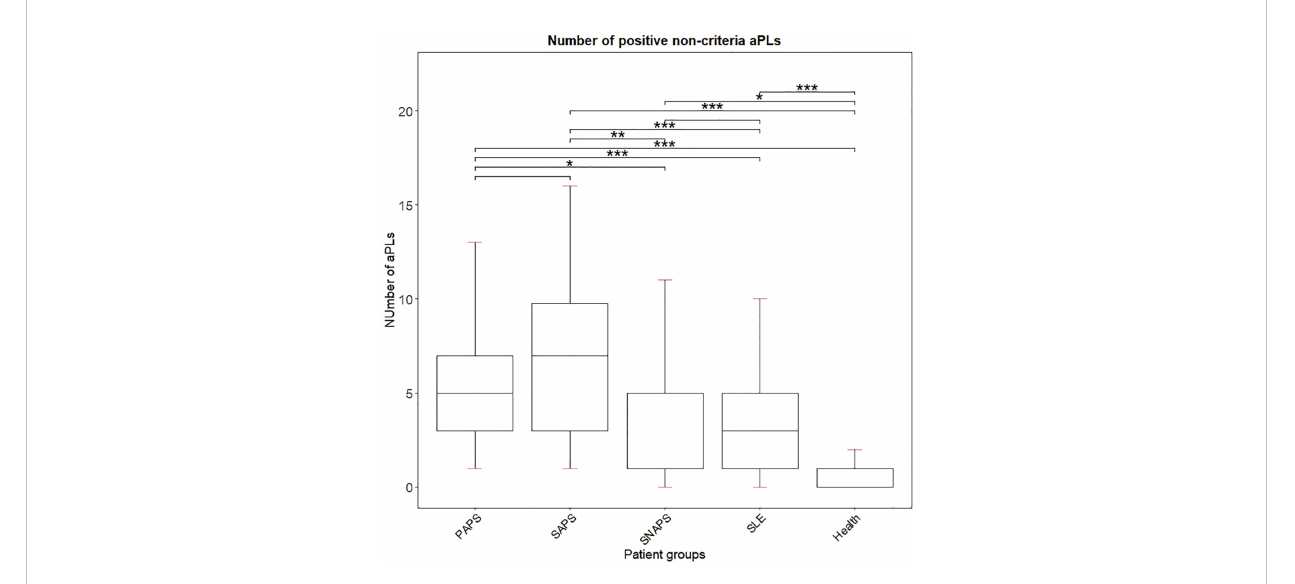
FIGURE 2 Number of positive non-criteria aPLs for each disease group. ***p < 0.001; **p < 0.01; *p <